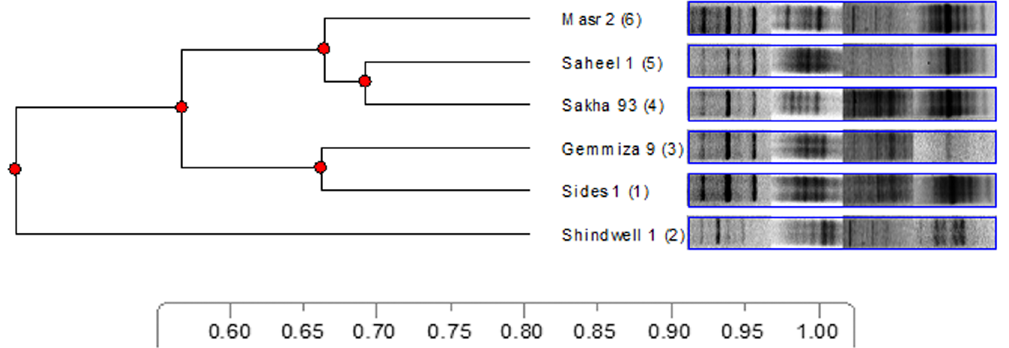
Figure 4: Dendrogram showing the phylogenetic relationships and resulted clusters for the six wheat varieties. 1 - Sides 1,2 - Shindwell